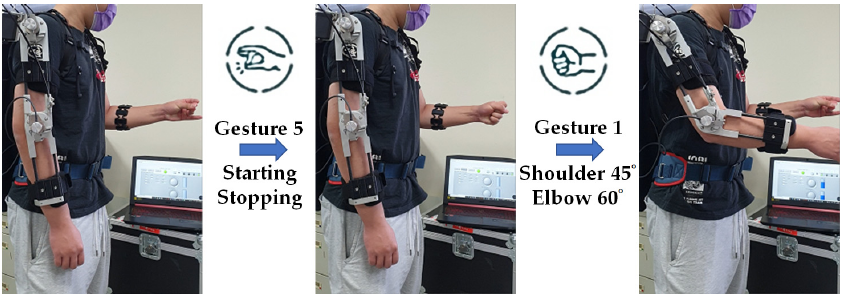
Figure 32. Desired action experiment with a shoulder flexion angle of 45° and an elbow flexion angle of 60°.